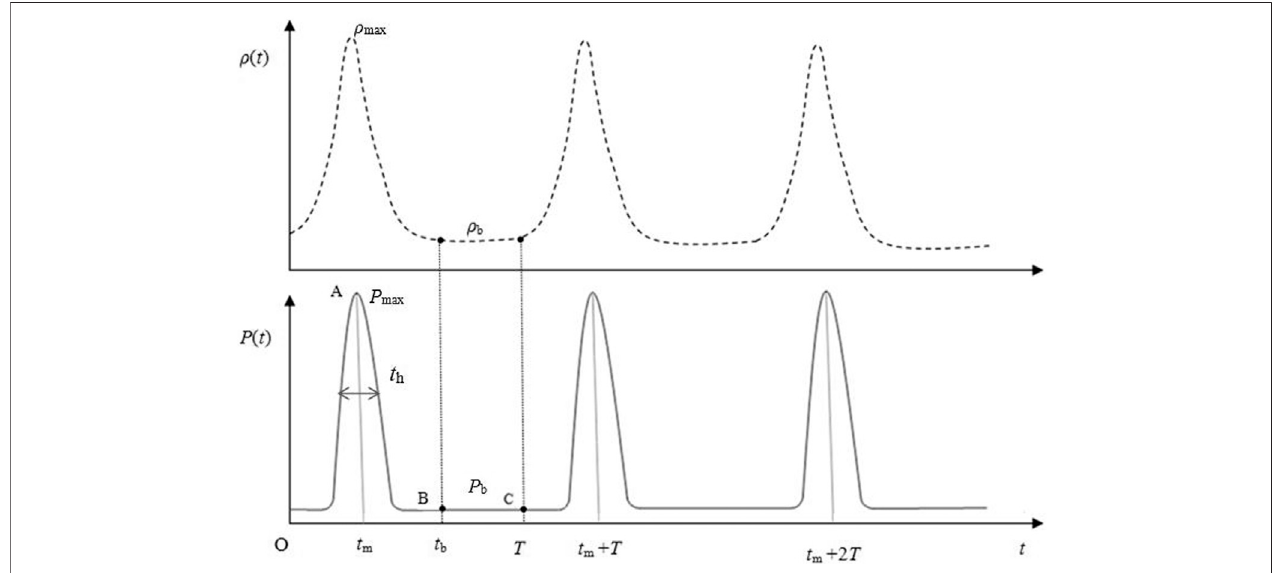
FIGURE 5 | Power and reactivity change of the fast periodic pulsed reactor.